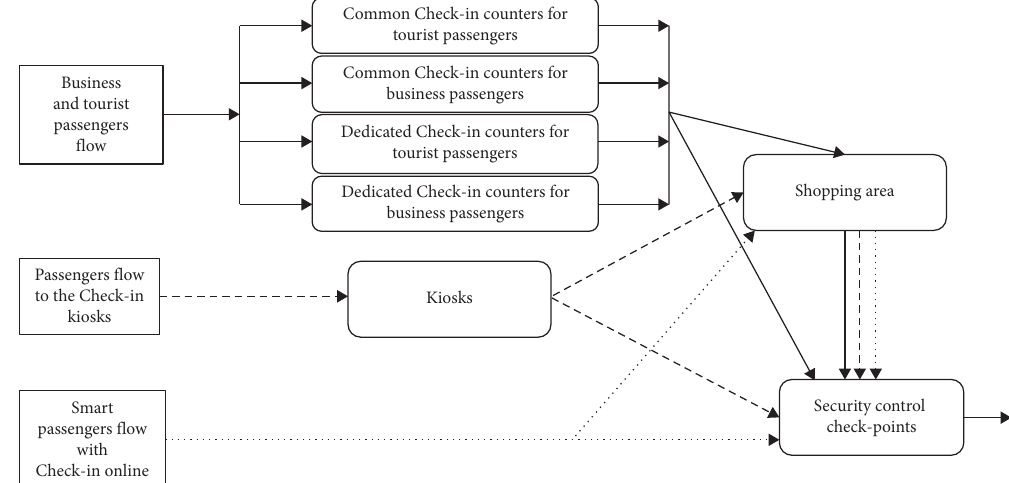
Figure 2: Schema of passengers’ flow in the land side